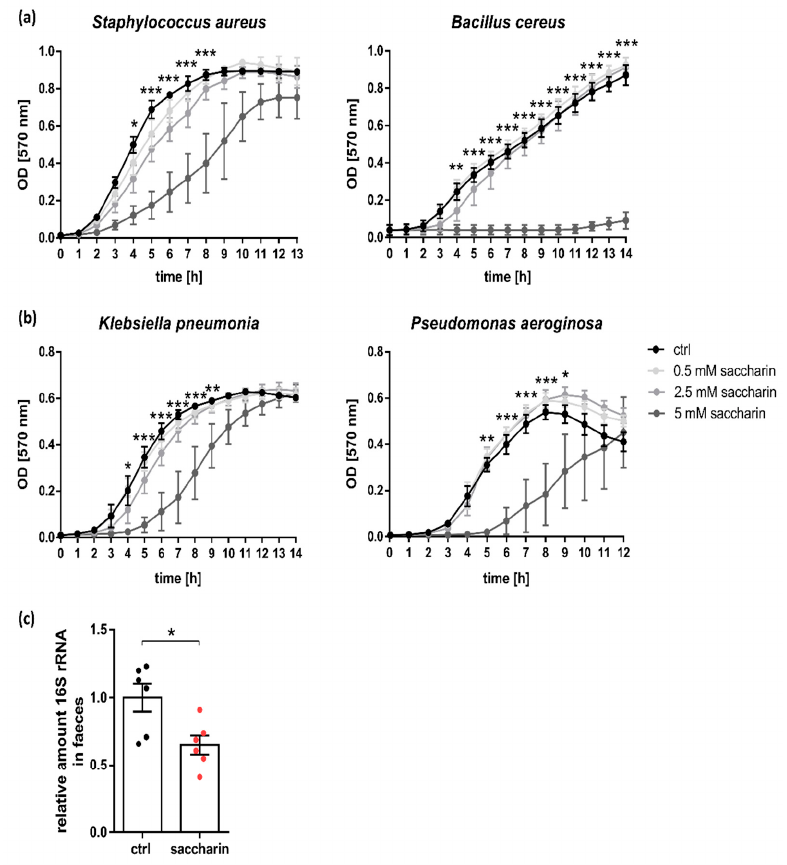
Figure 1. Saccharin inhibits bacterial growth in vitro and in vivo. Bacterial growth curves of ( a ) Firmicutes and ( b ) Proteobacteria in the presence or absence of di ff erent saccharin concentrations; n = 3. Statistical significance is shown for 5 mM saccharin versus ctrl analyzed by two-way ANOVA followed by Tukey testing for multiple comparisons. ( c ) Bacterial load in the feces after 35 days of saccharin supplementation or ctrl feeding was quantified by PCR and is shown as relative amount of 16S rRNA to ctrl; n = 6. Values are shown as mean ± SEM. * p ≤ 0.05; ** p ≤ 0.01; *** p ≤ 0.001.